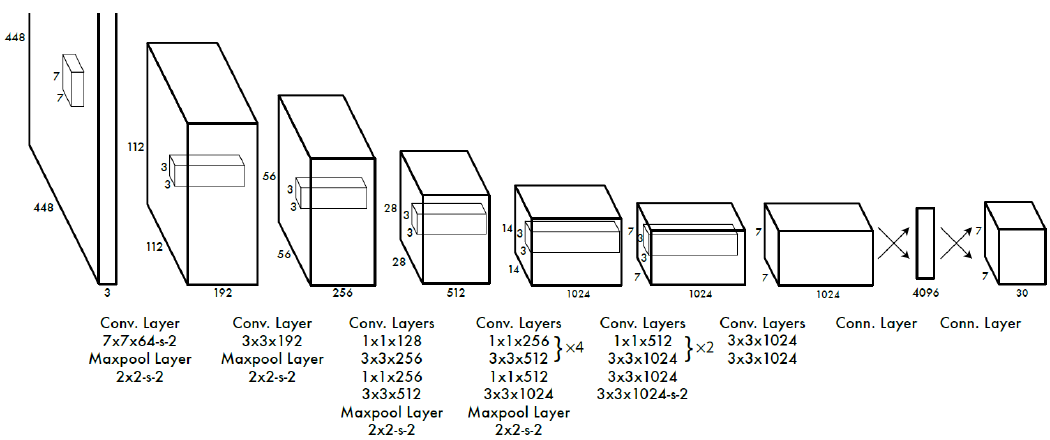
Figure 3. Basic network architecture of the YOLO framework. It has a Convolutional Neural Network (CNN) with over 20 connected layers. Source